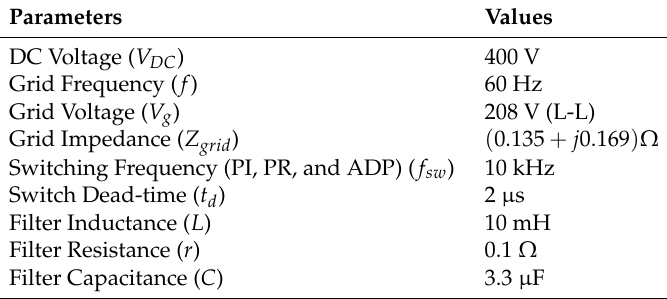
Table 1. Simulation parameters; PI: proportional-integral; PR: proportional-resonant; ADP: adaptive dynamic